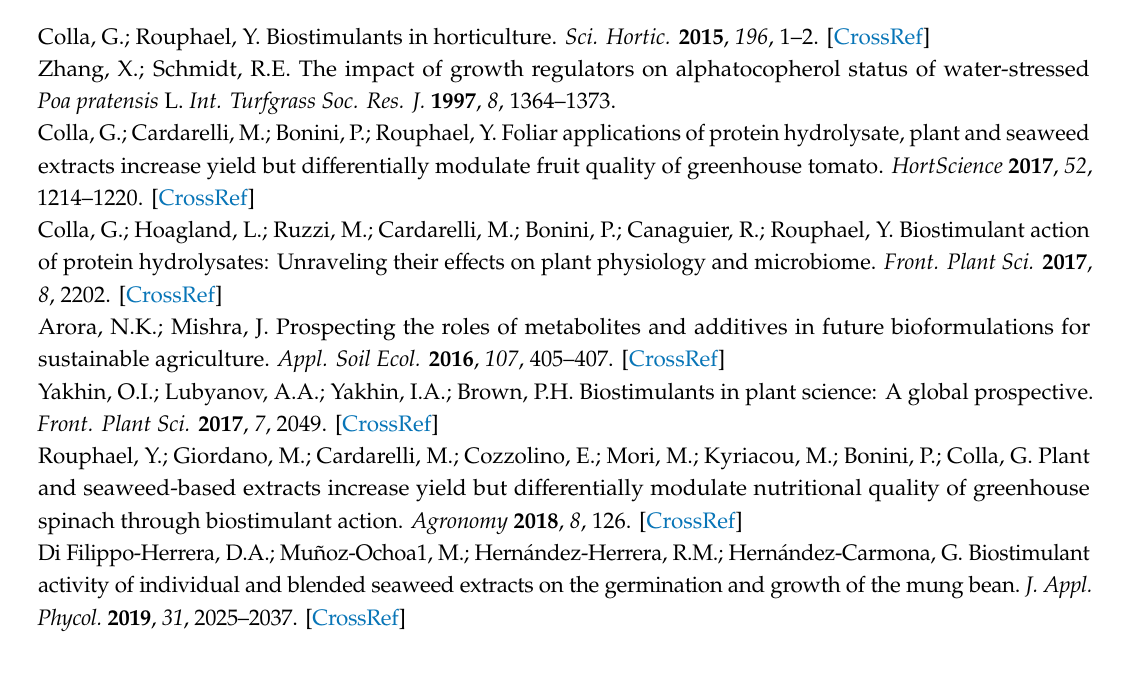
Table S1: Relative and cumulative percentage of total variance, eigen values and correlation coe ffi cients of all agronomical and qualitative parameters of perennial wall rocket harvested three times during the cultivation cycle (HRV1, HRV2 and HRV3) with respect to the two principal components (PC1 and PC2). Author Contributions: Conceptualization, Y.R. and G.C. (Giuseppe Colla); methodology, Y.R. and G.C. (Gianluca Caruso); software, C.E.-N.; validation, G.C. (Gianluca Caruso), M.G., and C.E.-N.; formal analysis, M.G. and